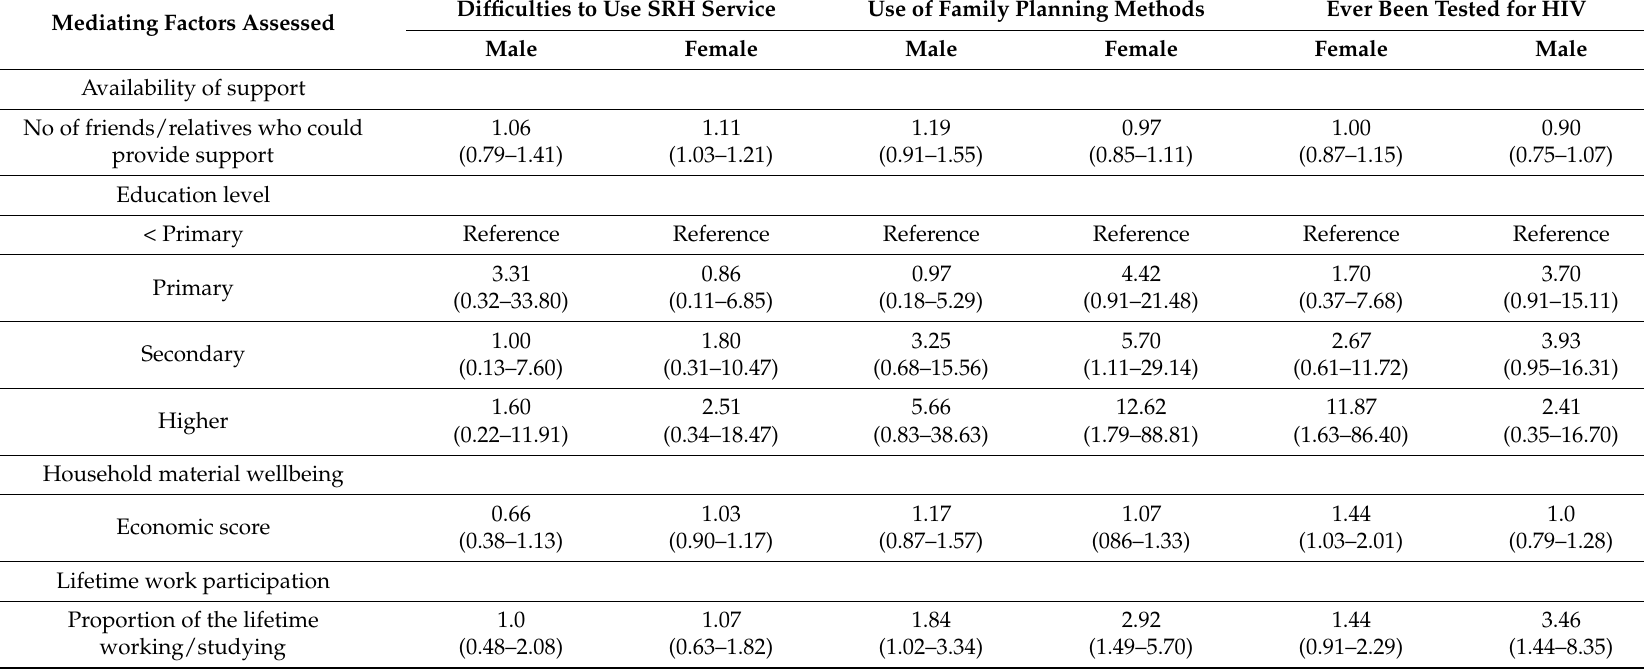
Table 2. Association between socioeconomic mediators and outcomes related to access to sexual and reproductive health services in male and female participants with and without